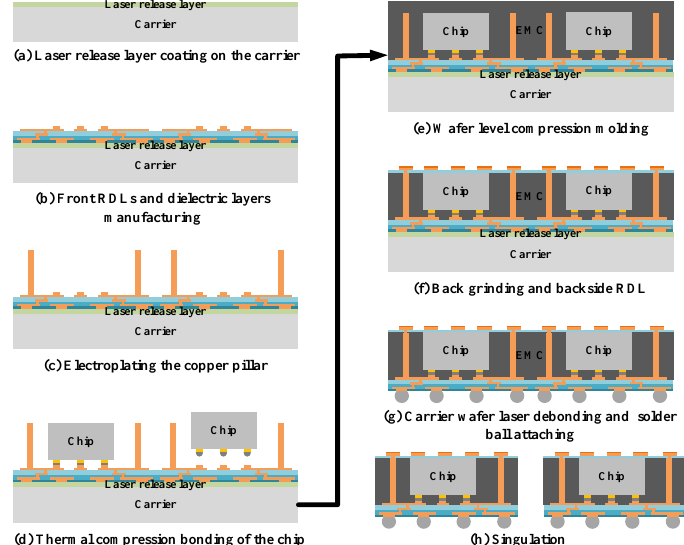
Figure 2. Process flow of the RDL-First FOWLP. Reprinted with permission from [34]. 2022, IEICE.